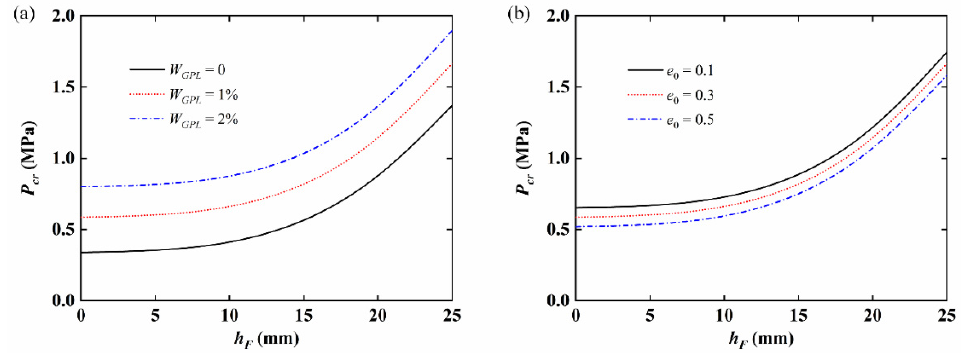
Figure 12. Variations in critical pressure of ring-stiffened porous GPLRC cylindrical shells with ring-stiffener height for different ( a ) weight fractions and ( b ) porosity coefficients.